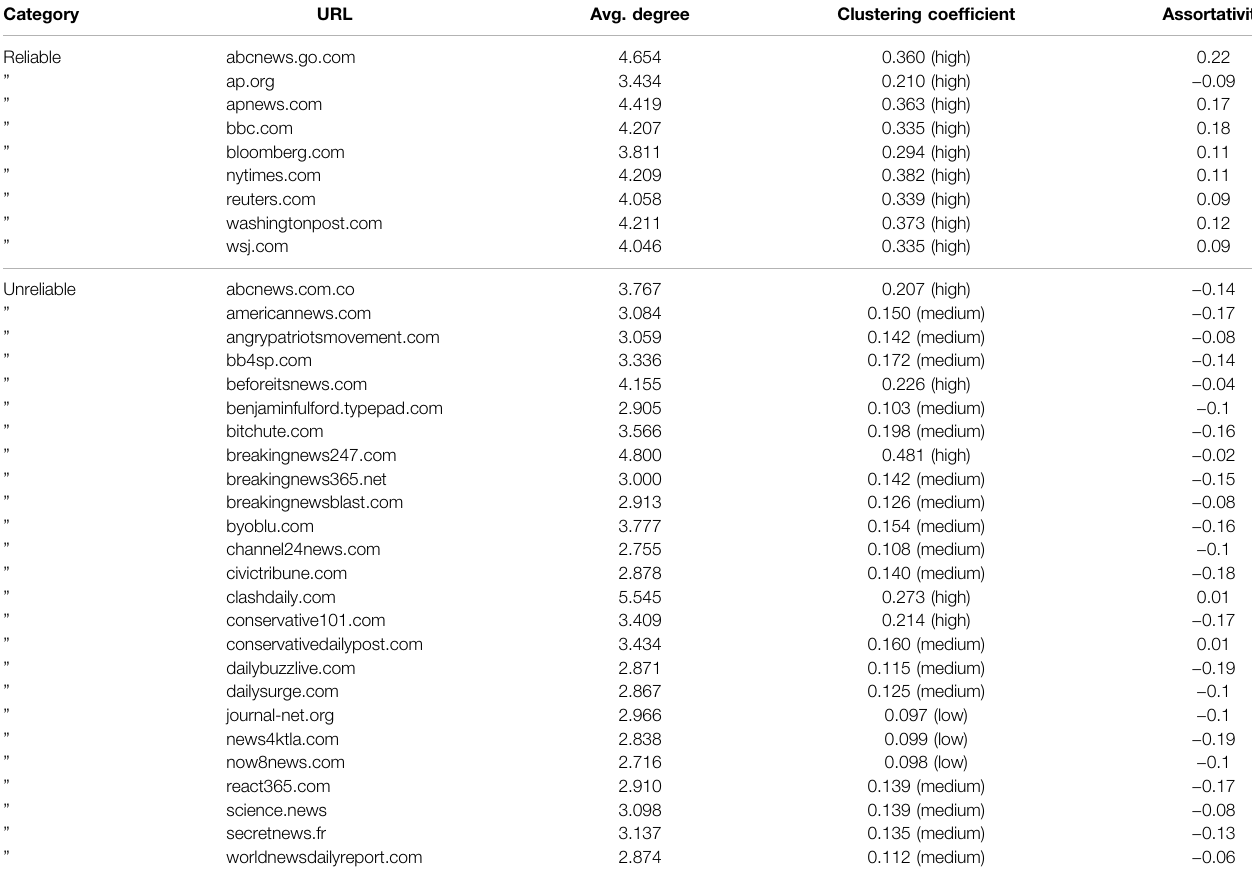
TABLE 3 | Average degree, clustering coef fi cient, and assortativity of network datasets of reliable news sources versus unreliable news sources. Reliable news sources are generallypositivelyassortative,withlinksbetweenwebsiteswithsimilarcharacteristics,asopposedtounreliableones.Sub-networkscanalsobeclassi fi edbyclustering coef fi cient.Byinvestigatingtheunreliablewebsites, theclusteringcoef fi cientrangesfrom “ low ” (0)to “ medium ” (0.2)overall,whiletheclusteringcoef fi cientofreliablewebsite sub-networks has higher values. This denotes that communities of websites sharing reliable news tend to be more clustered than unreliable ones.